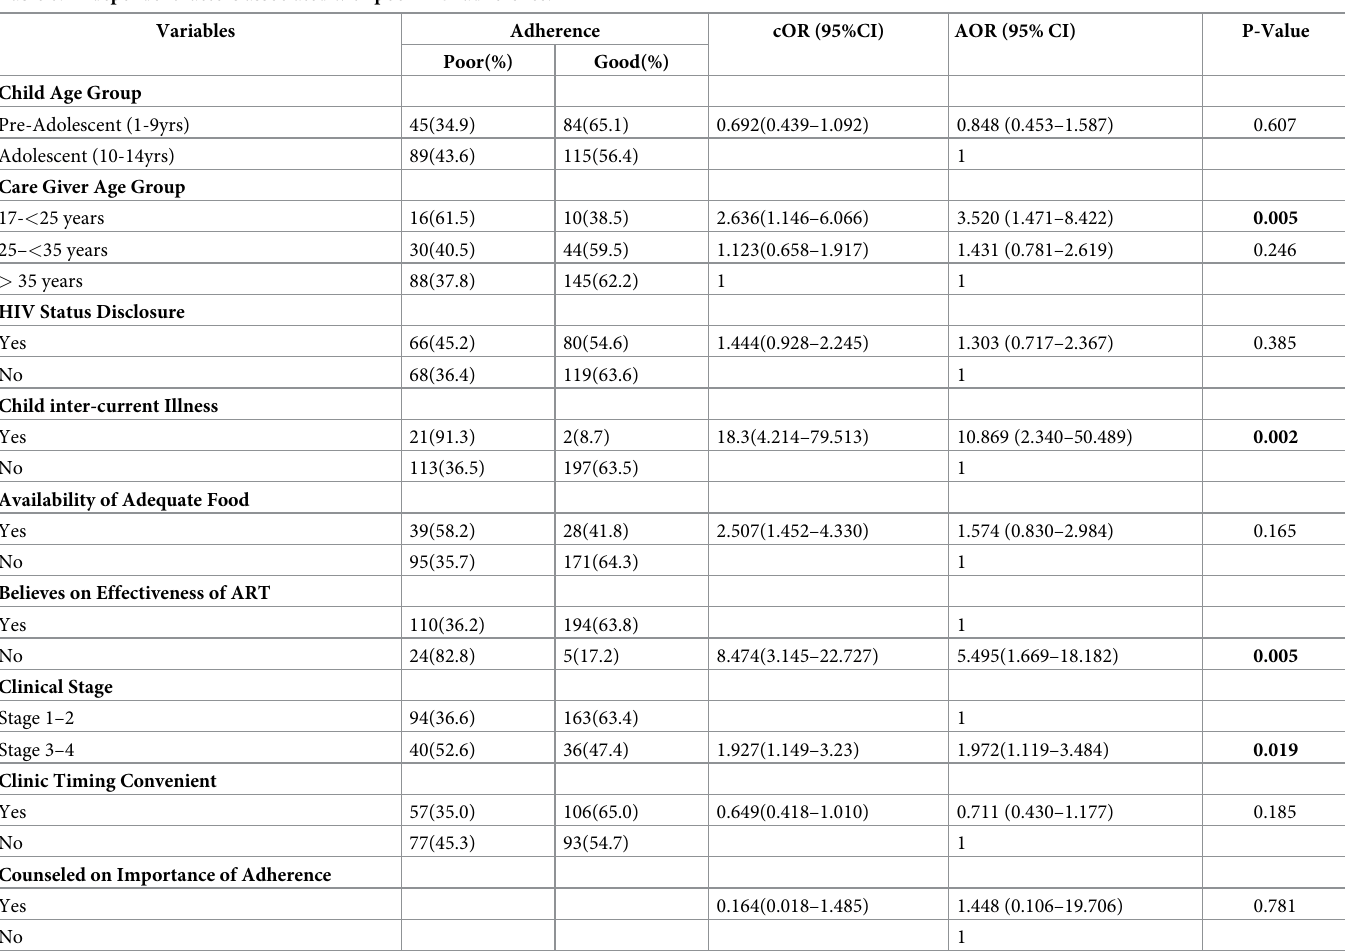
Table 6. Independent factors associated with poor ART